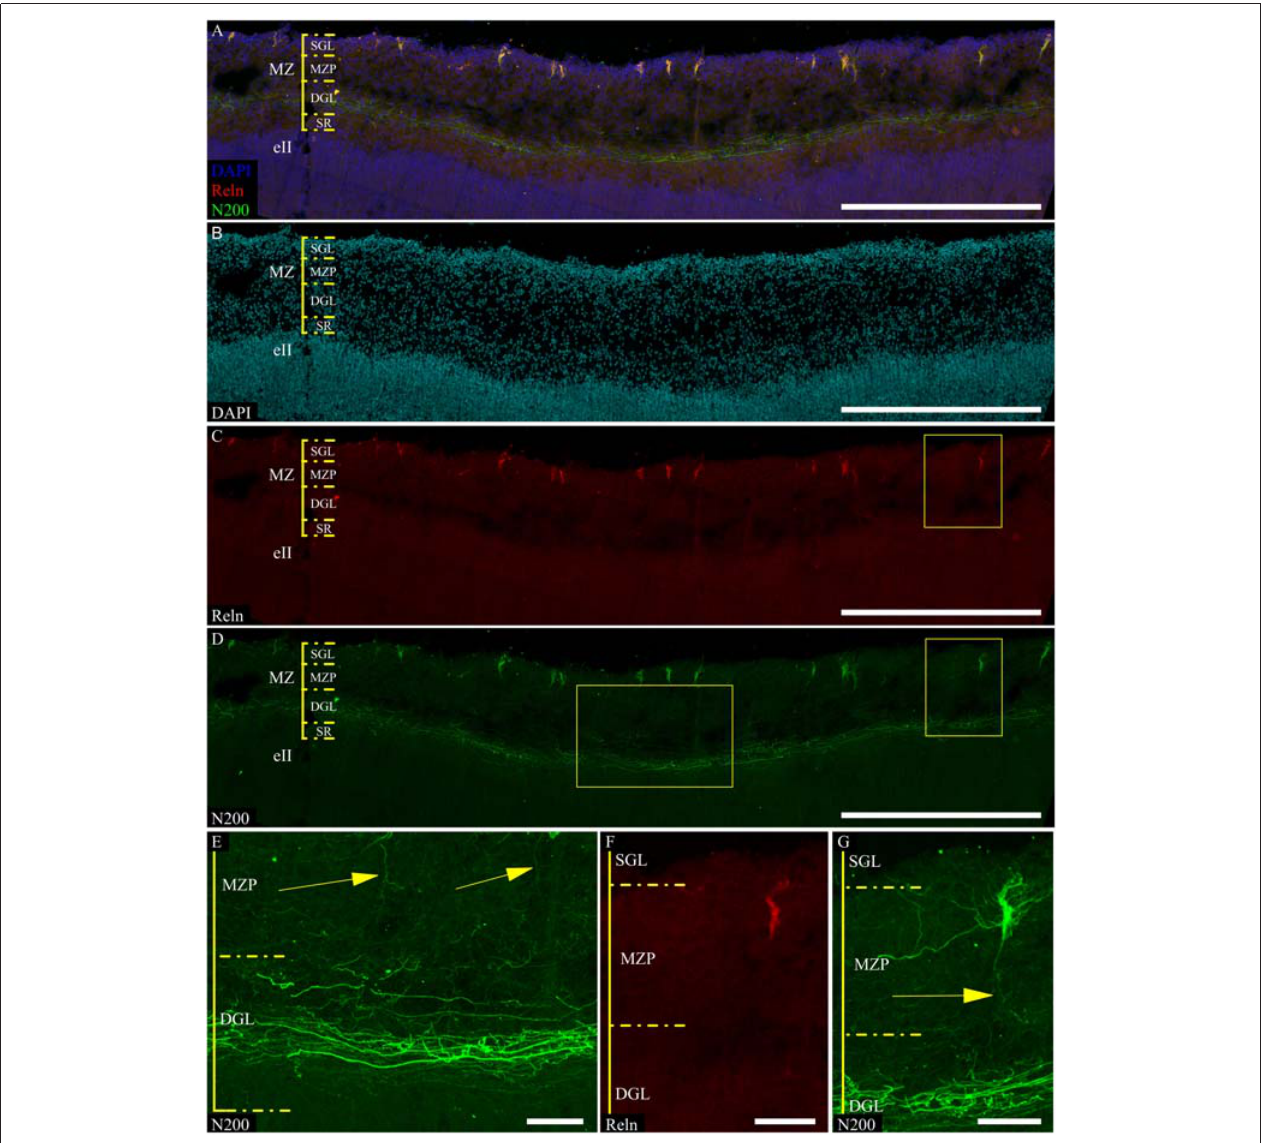
FIGURE 4 | C–R neurons in the MZ fetal postcentral gyrus at GW 24. (A–D,F,G) C–R cells stained for N200 using monoclonal N200 antibody (green), Reelin (red), DAPI (blue (A) , cyan (B) , frozen section. Boxes show the position of the area given at a higher magnification in (E–G) . (E) N200-positive plexus. Arrows indicate descending C–R cells processes. Scale bars: (A–D) 500 µ m; (E–G) 50 µ